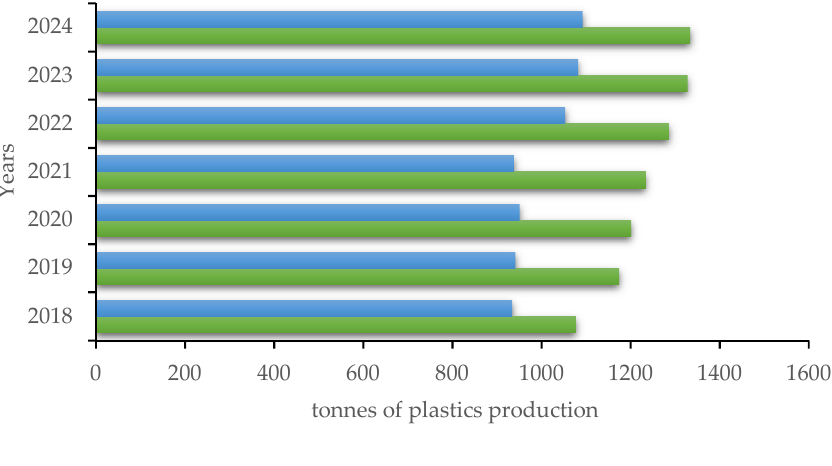
Figure 3. Forecast of the bioplastics production in tons from 2019 to 2024.